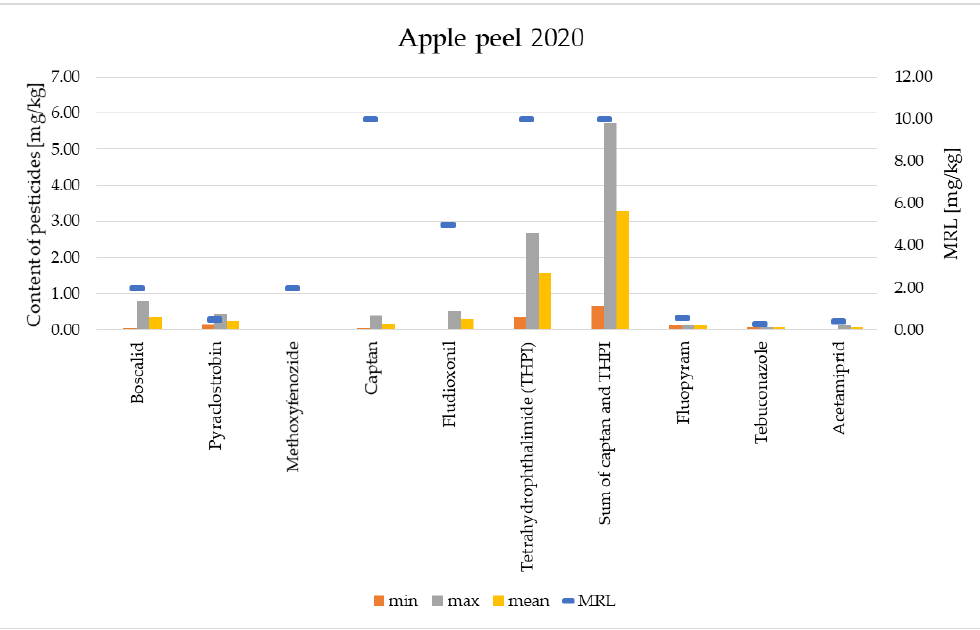
Figure 8. Content of pesticides in samples of peels of apples from the harvest of 2020.